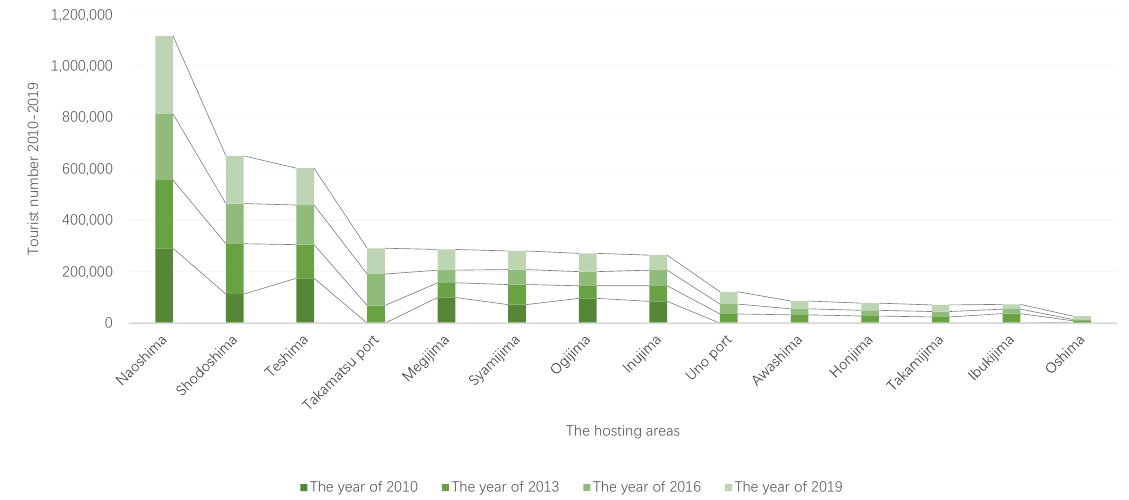
Figure 6. Tourist number and its growth rate of ST from 1994 to 2019.